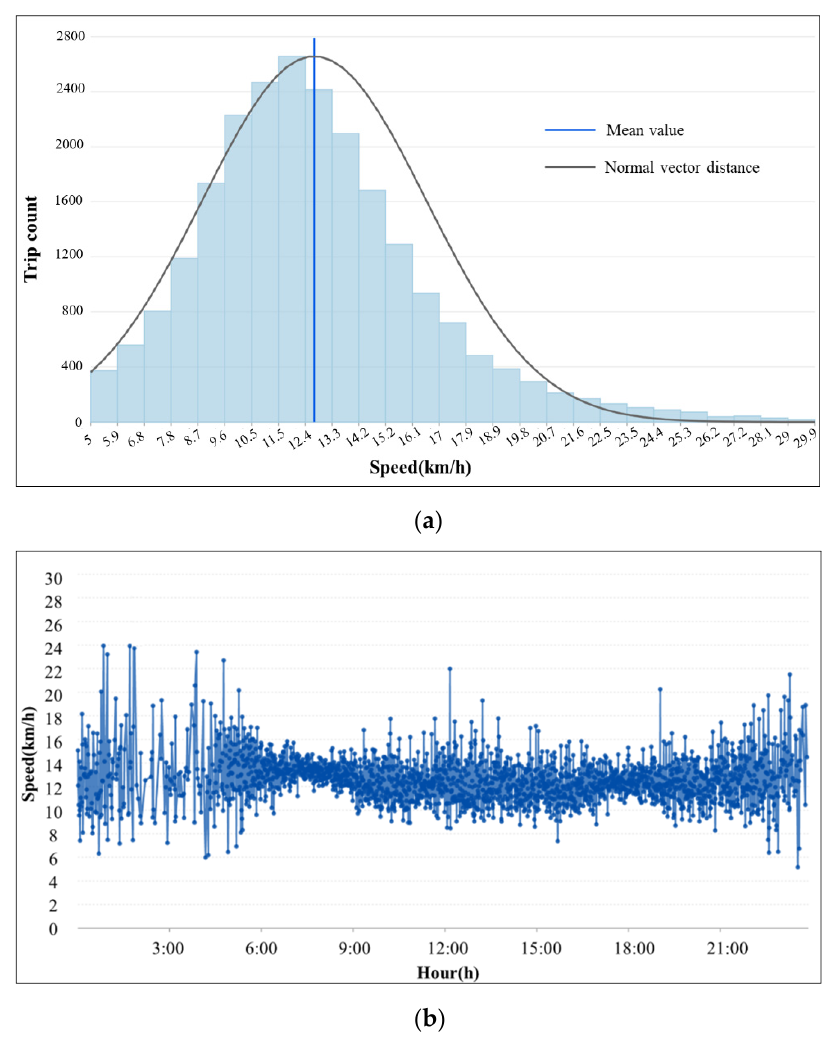
Figure 5. Descriptive statistics of cycling rhythms volatility. ( a ) volatility of trip count variation; ( b ) volatility of time variation.